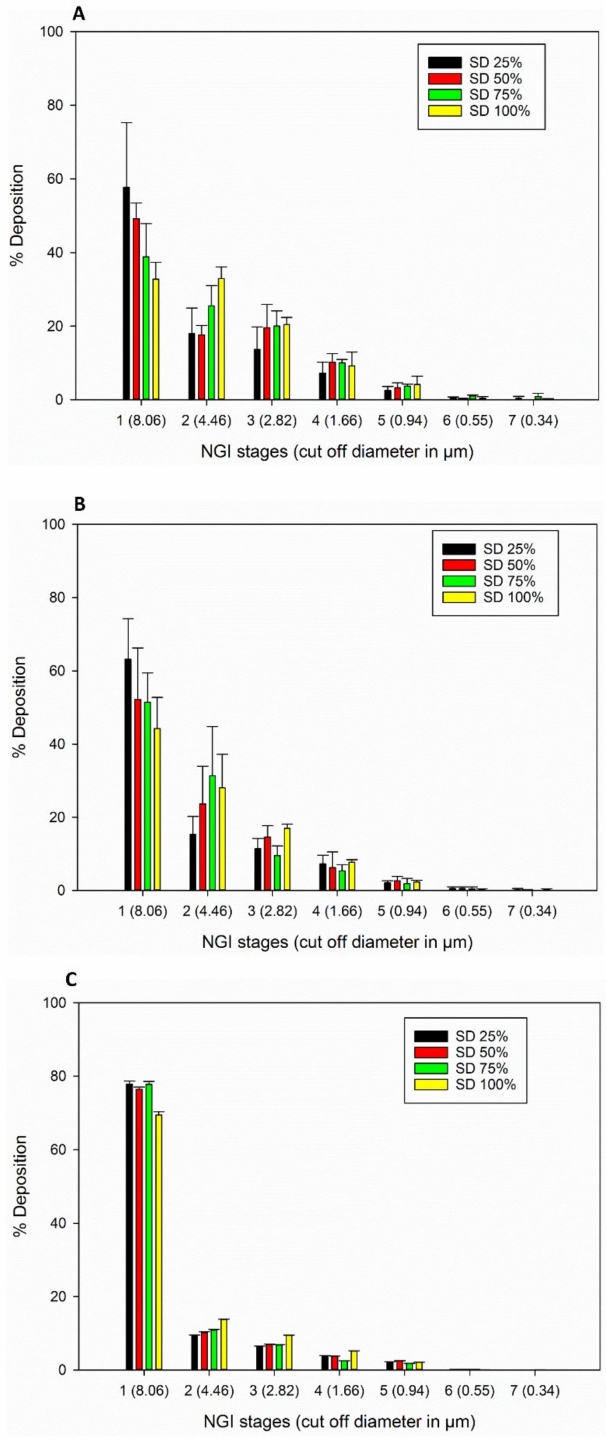
Figure 9. In vitro aerosol dispersion performance of SD FAS powders from all 4 spray drying pump rates using the NGI and the FDA-approved human DPI devices: ( A ). Aerolizer ® ; ( B ). Neohaler ® ; and ( C ). HandiHaler ®